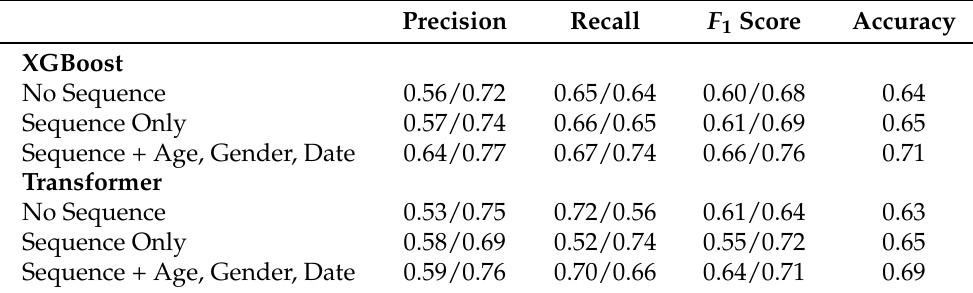
Table 3. Classification metrics for the patient metadata validation set for the neural network model of Figure 1 and XGBoost model trained on individual samples. Prediction results shown are based on training on age, gender, and date as the only independent variables, sequence alone, and the sequence combined with other variables. There are 8948 and 12,965 samples of Mild and Severe patient outcomes respectively. Because of the imbalanced classes, the class-specific metrics are shown here in addition to overall accuracy. The value on the left of the forward slash corresponds to the Mild class, and the value on the right to the Severe class. Classification accuracy of the Transformer-based neural network model approaches 70% and is comparable to